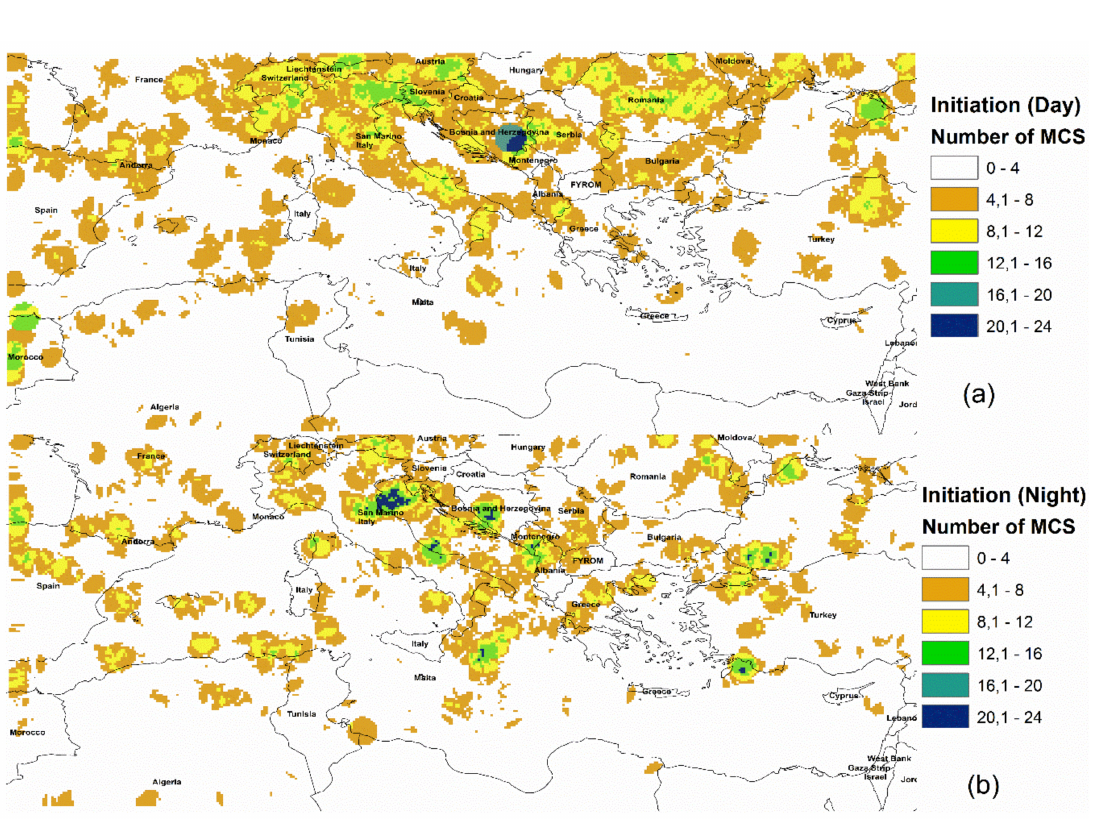
Figure 3. Spatial density of occurrence of MCSs with at least one CC localmax event during ( a ) daytime; ( b )